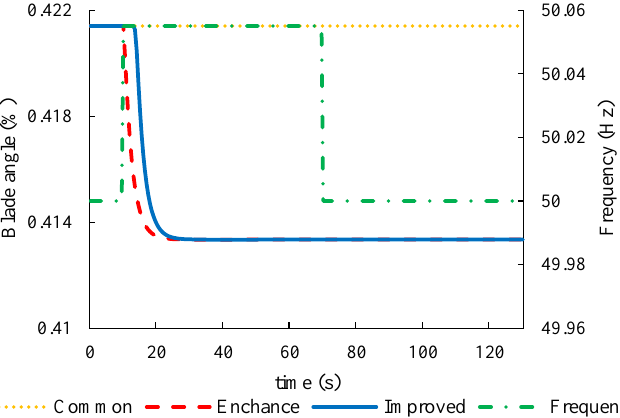
Figure 15. The blade angle curve of PFC with common, enhanced, and improved frequency dead zones.